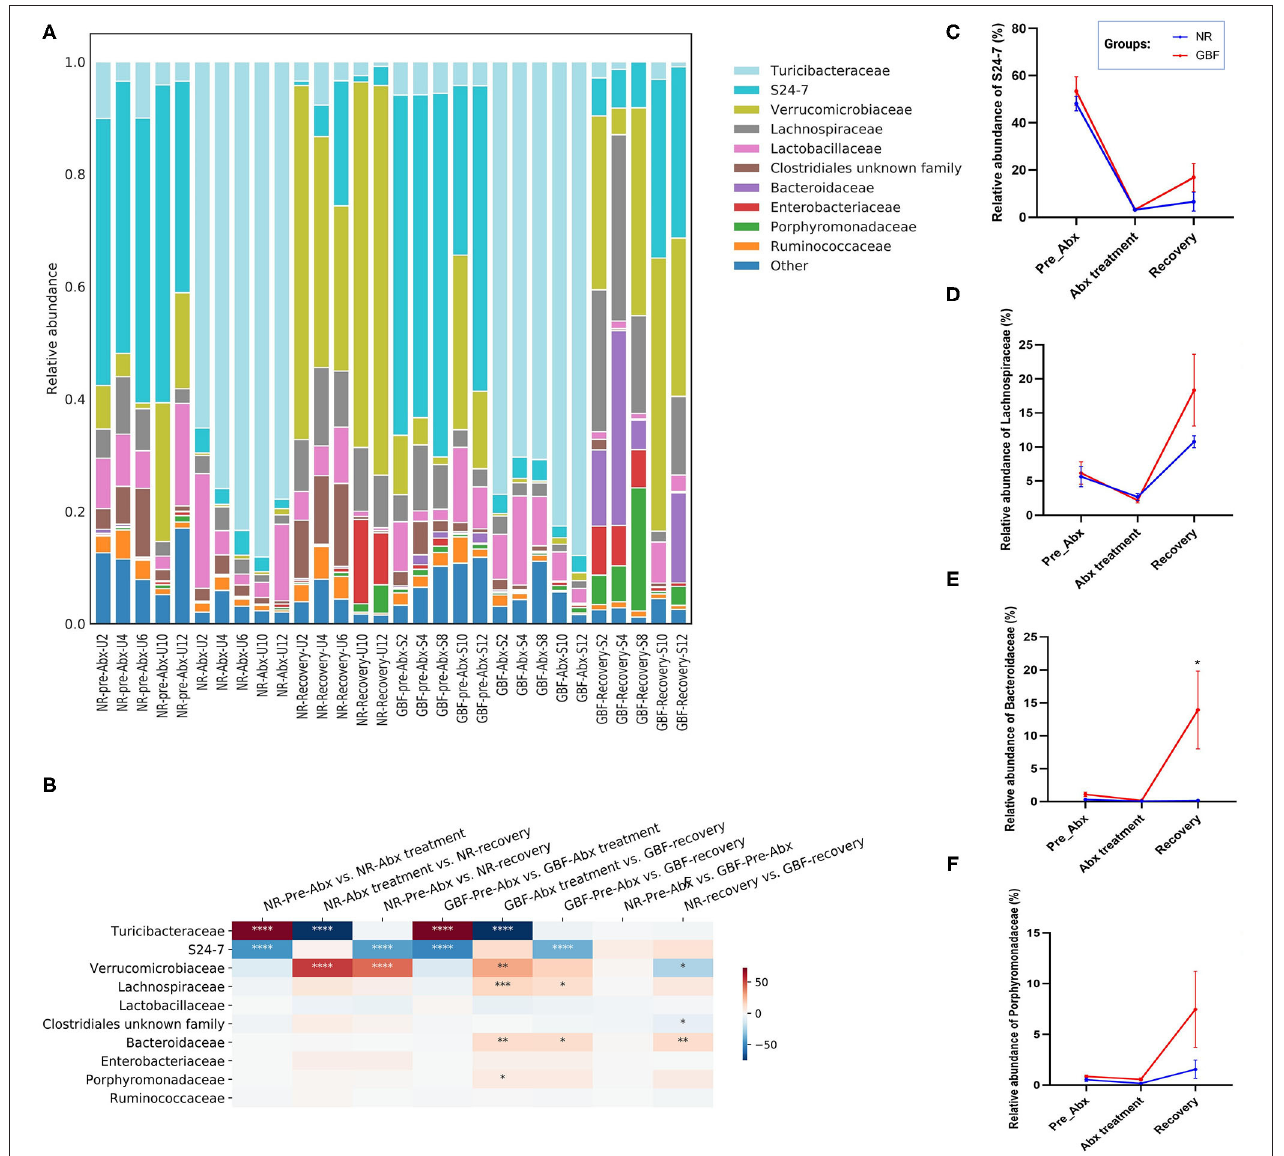
FIGURE 6 | Gut microbiota composition differences at the family level. (A) Microbiota composition differences. (B) Only the 10 more abundant families were represented and compared. Significance was determined using one-way analysis of variance corrected for multiple comparisons with a Tukey’s test, n = 5 per group. * P < 0.05, ** P < 0.01, *** P < 0.001, **** P < 0.0001. (C–F) The relative abundance of S24-7, Lachnospiraceae, Bacteroidaceae, and Porphyromonadaceae from both groups were compared throughout the experiment. Significance was determined using two-tailed unpaired t -tests. The values are expressed as the means ± SEM., n = 5 per group. * P <